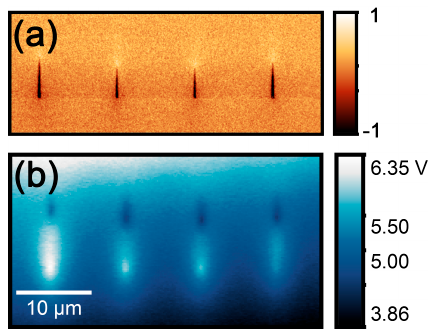
Figure 2. Domain arrays produced by the local polarization reversal on the Y-cut of MgOLN at the 5% relative humidity: ( a ) PFM image; ( b ) KPFM image. Spacing between the points of bias application was 10 µm, and the pulse amplitude was 100 V. The scale is equal for (a,b).